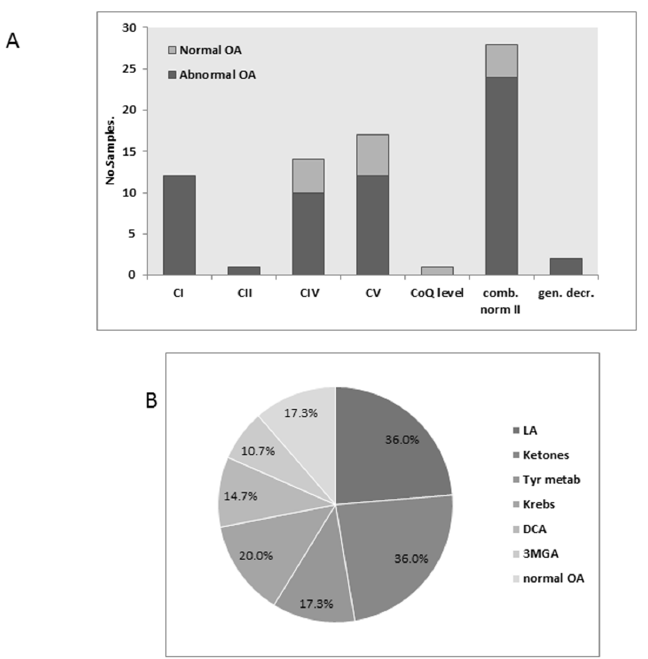
Figure 4. Urinary organic acids: ( A ) The relative proportion abnormal to abnormal urinary organic acids (OA) tests results according to groups. ( B ) The relative proportion of the most common abnormalities.